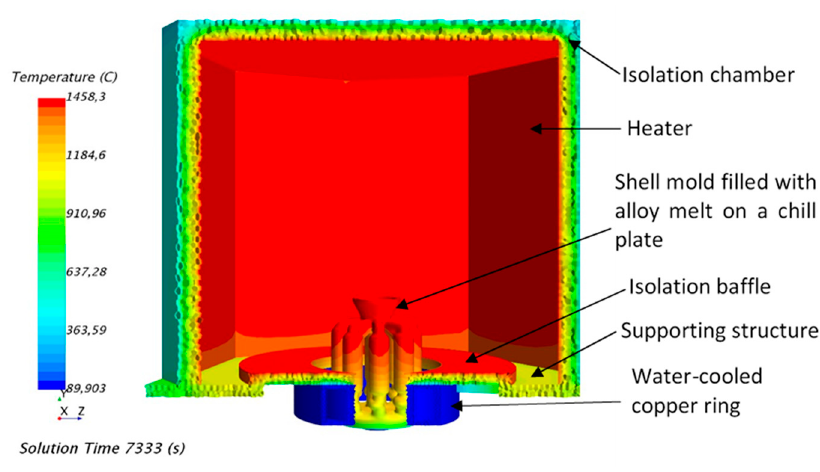
Figure 4. The simulation models of the Bridgman furnace.